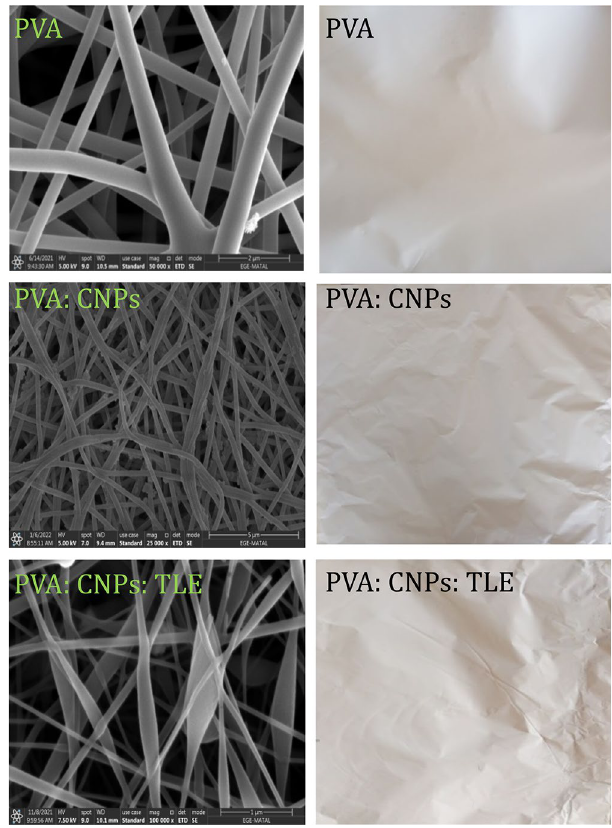
Figure 4. SEM and raw scaffolds of PVA, PVA: CNPs, PVA: CNPs: